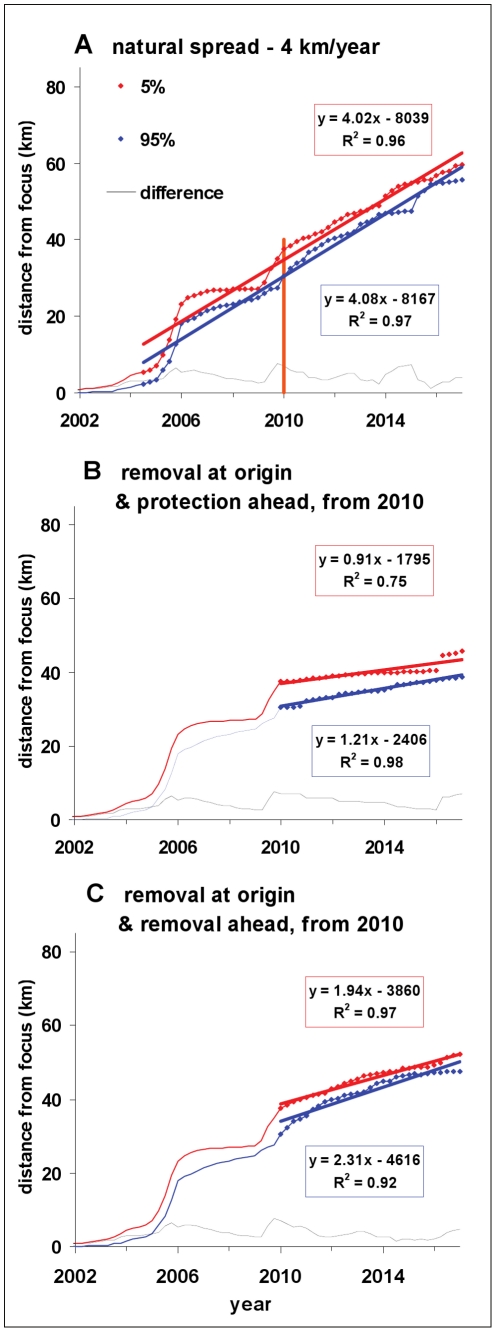
Speed and location of the cryptic epidemic front in Humboldt County up to 2017.
A) We predict that the front moves north of the focus with average speed ∼4 km/year and in 2010 is located 28 to 35 km north of Redway (i.e., 31 to 38 km north of the estimated centre of the focus; see orange vertical line). If control were initiated in 2010 the front would slow down to: B) ∼1 km/year, with removal “at the origin” and host protection “ahead of the origin”, although in 2016 the front would jump over the protected area and speed up (Fig. 4E); and C) ∼2 km/year, with removal “at” and “ahead of the origin” (Fig. 5D). The annual weather pattern in each year after 2010 equals the average during 2000–2009. The red and blue curves show the locations where the probability of pathogen invasion is 5% and 95%, respectively, which we use to define the moving front of the epidemic. The speed of the moving front is bounded by the slopes of the straight lines that approximate the iso-probability curves. The position of the front at given time is bounded by these curves; the distance between them (black line) provides a measure of uncertainty associated with chance variation in the spread of infection. When there is control, the lines are fitted to the post-control period to avoid influence by past conditions, while for natural spread a broader period is allowed including past and future.